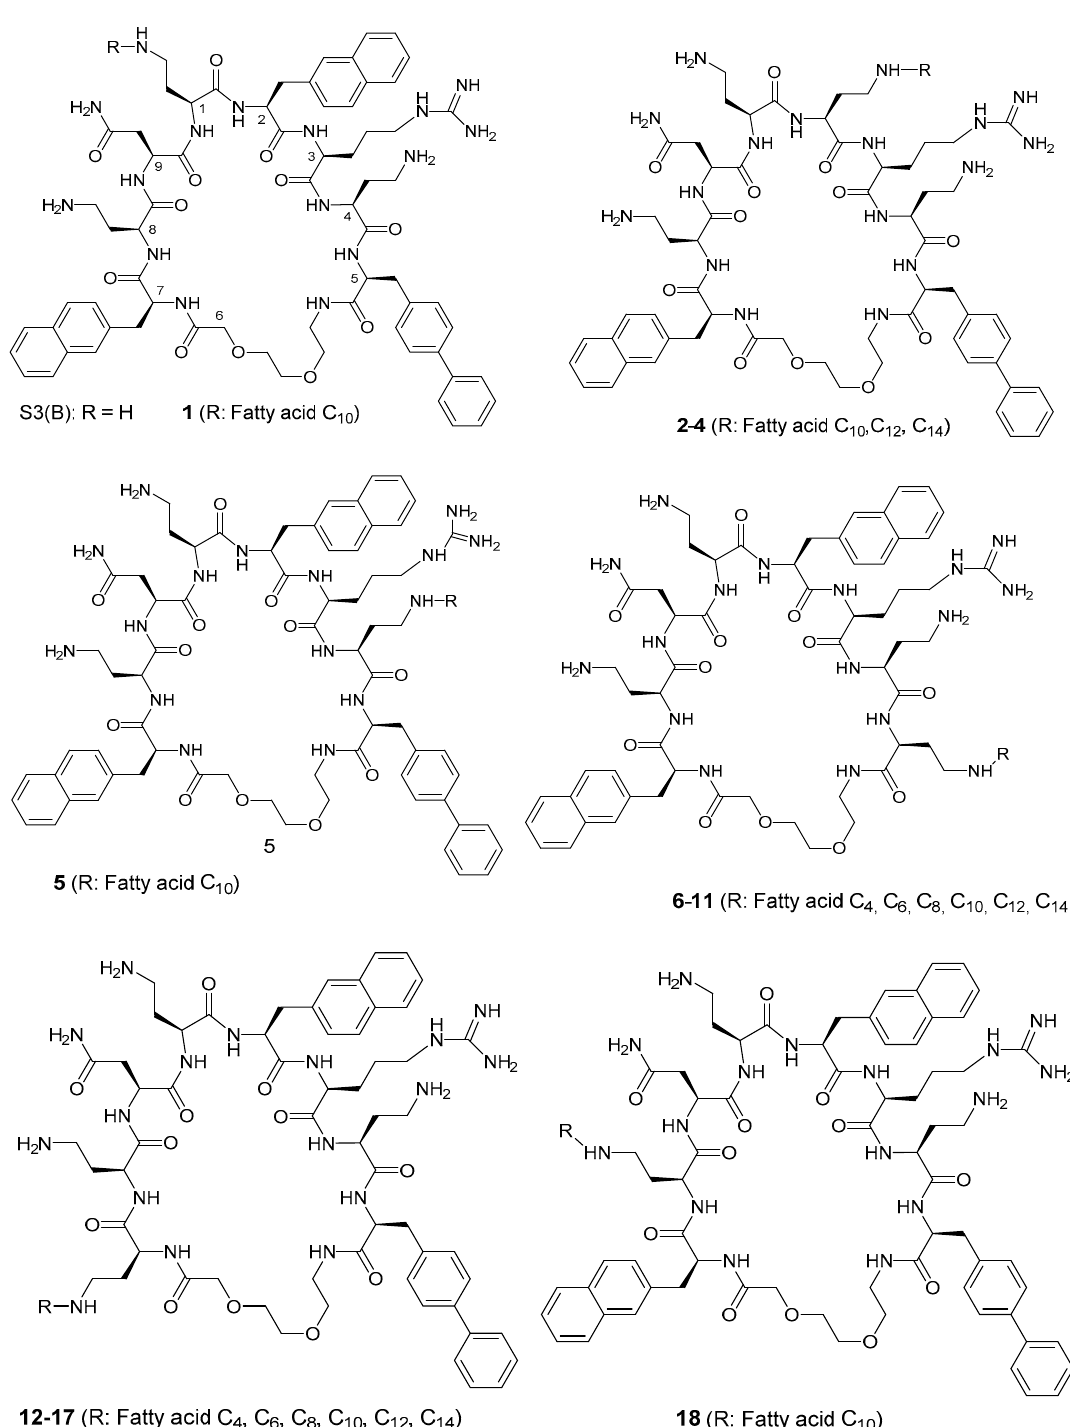
Figure 1. Structure of fatty acid S3(B) analogues studied in this paper.